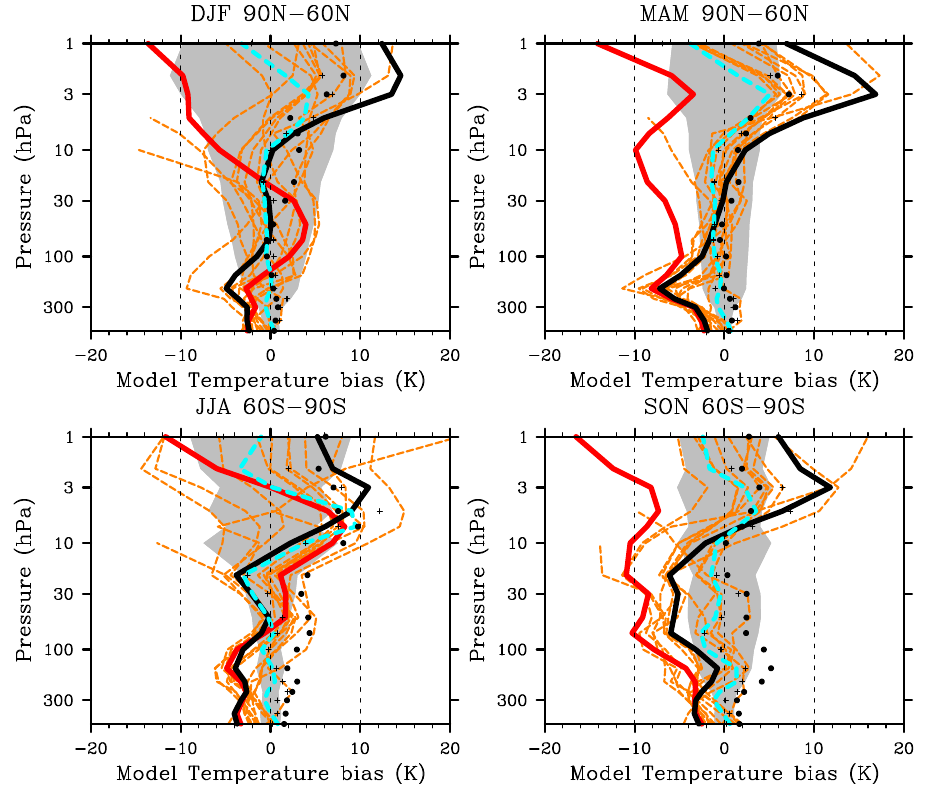
Fig. 1. Temperature biases over two latitude ranges, 90 ◦ N–60 ◦ N (first row) and 60 ◦ S–90 ◦ S (second row), and two seasons, winter (left column) and spring (right column). Biases are relative to the ERA-40 1980–2001 monthly reanalysis, for CNRM-ACM (red line), CNRM-CCM (black line) and CCMVal-2 REF-B1 models (dashed orange lines), and for ERA-Interim (dashed cyan line), NCEP (dots), and UKMO (crosses) reanalyses. The grey area shows ERA-40 ± 1 standard deviation.